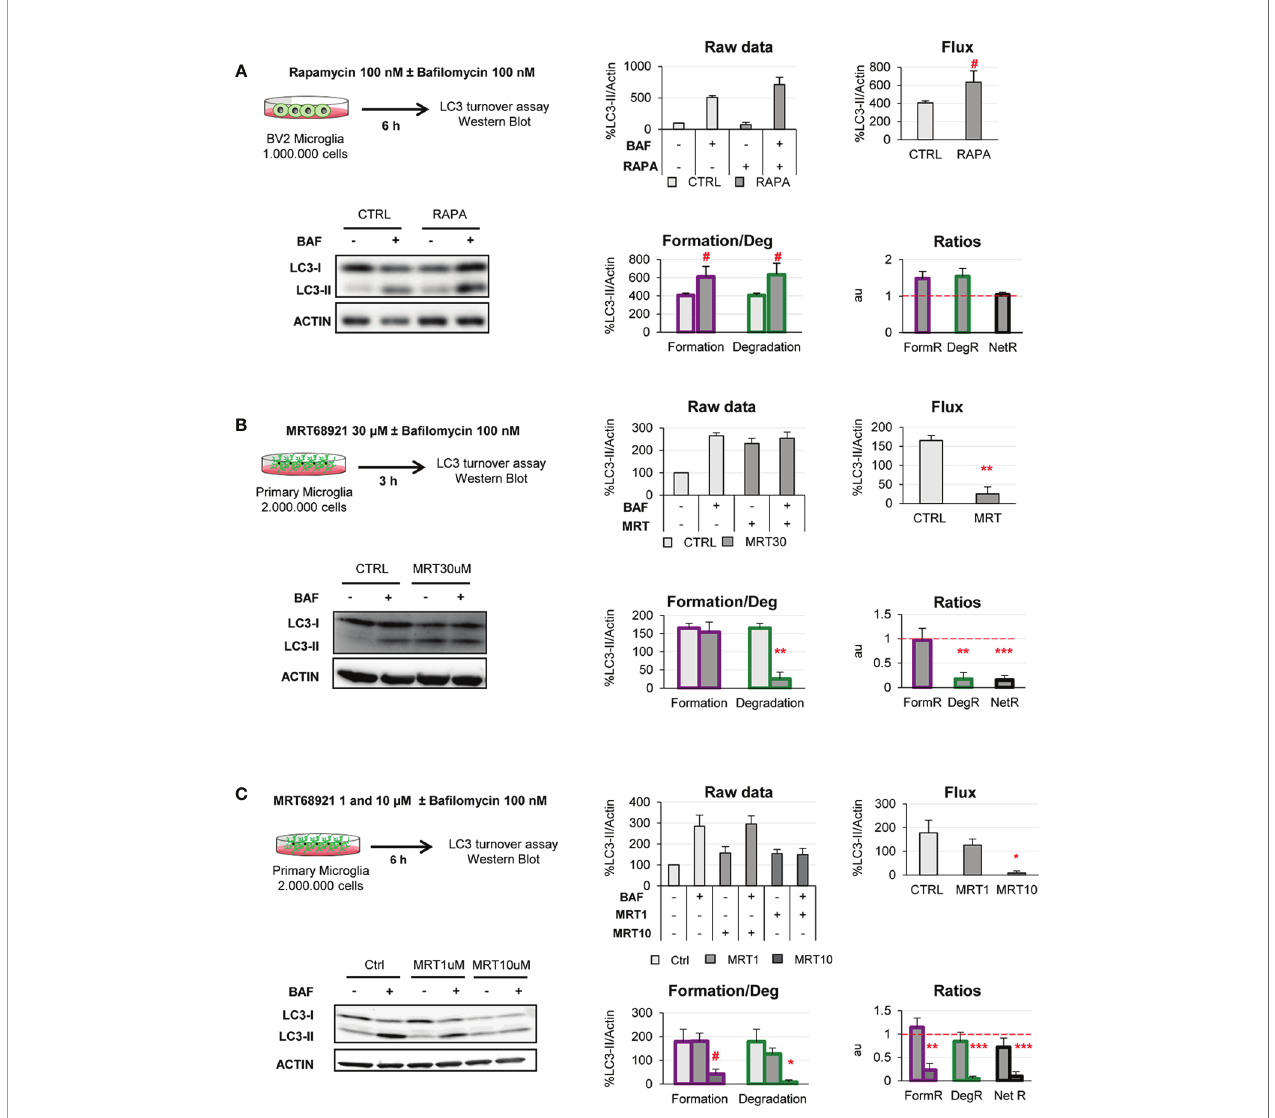
FIGURE 6 | Validation of the two-step model with autophagy modulating compounds. (A) Autophagy induction assessed after treatment with rapamycin (100 nM, 6 h) in the presence and absence of Ba fi lomycin (100 nM) in the BV2 microglia cell line. A representative blot, the raw data obtained, and the calculations of fl ux, autophagosome formation and degradation, and net turnover ratios are shown. Data is presented as % over control (LC3-II/actin). (B, C) Autophagy inhibition assessed after treatment with MRT68921 (30 m M, 3 h in (B) ; 1 and 10 m M, 6 h in (C) in the presence and absence of Ba fi lomycin (100 nM) in mouse primary microglia. A representative blot, the raw data obtained, and the calculations of fl ux, autophagosome formation and degradation, and net turnover ratios are shown. Data is presented as % over control (LC3-II/actin). Data represent mean ± SEM of 3 independent experiments. # represents p < 0.1, *represents p < 0.05 and ** represents p < 0.01 by one tailed Student t-test (A, B) , or Holm-Sidak after a signi fi cant effect of the treatment was found with 1-way ANOVA (C)